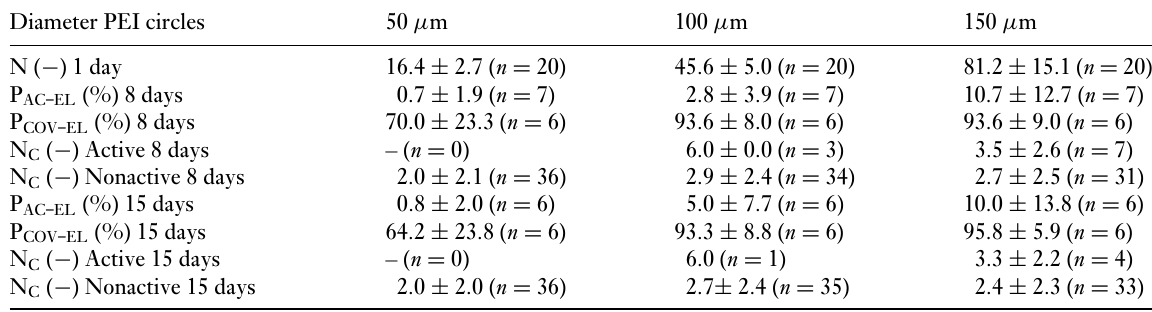
Table 1 N: the number of neurons adhering on microprinted PEI-circles with diameters of 50 µ m, 100 µ m, and 150 µ m after 1 day. P AC - EL : the percentage of corresponding electrically active electrodes on MEAs after 8 and 15 days. P COV - EL : the percentage of electrodes covered with neuronal cells on MEAs after 8 and 15 days. N C : the number of neuronal connections with the surrounding electrodes for electrically active electrodes and non-active electrodes after 8 and 15 days Diameter PEI circles 50 µ m